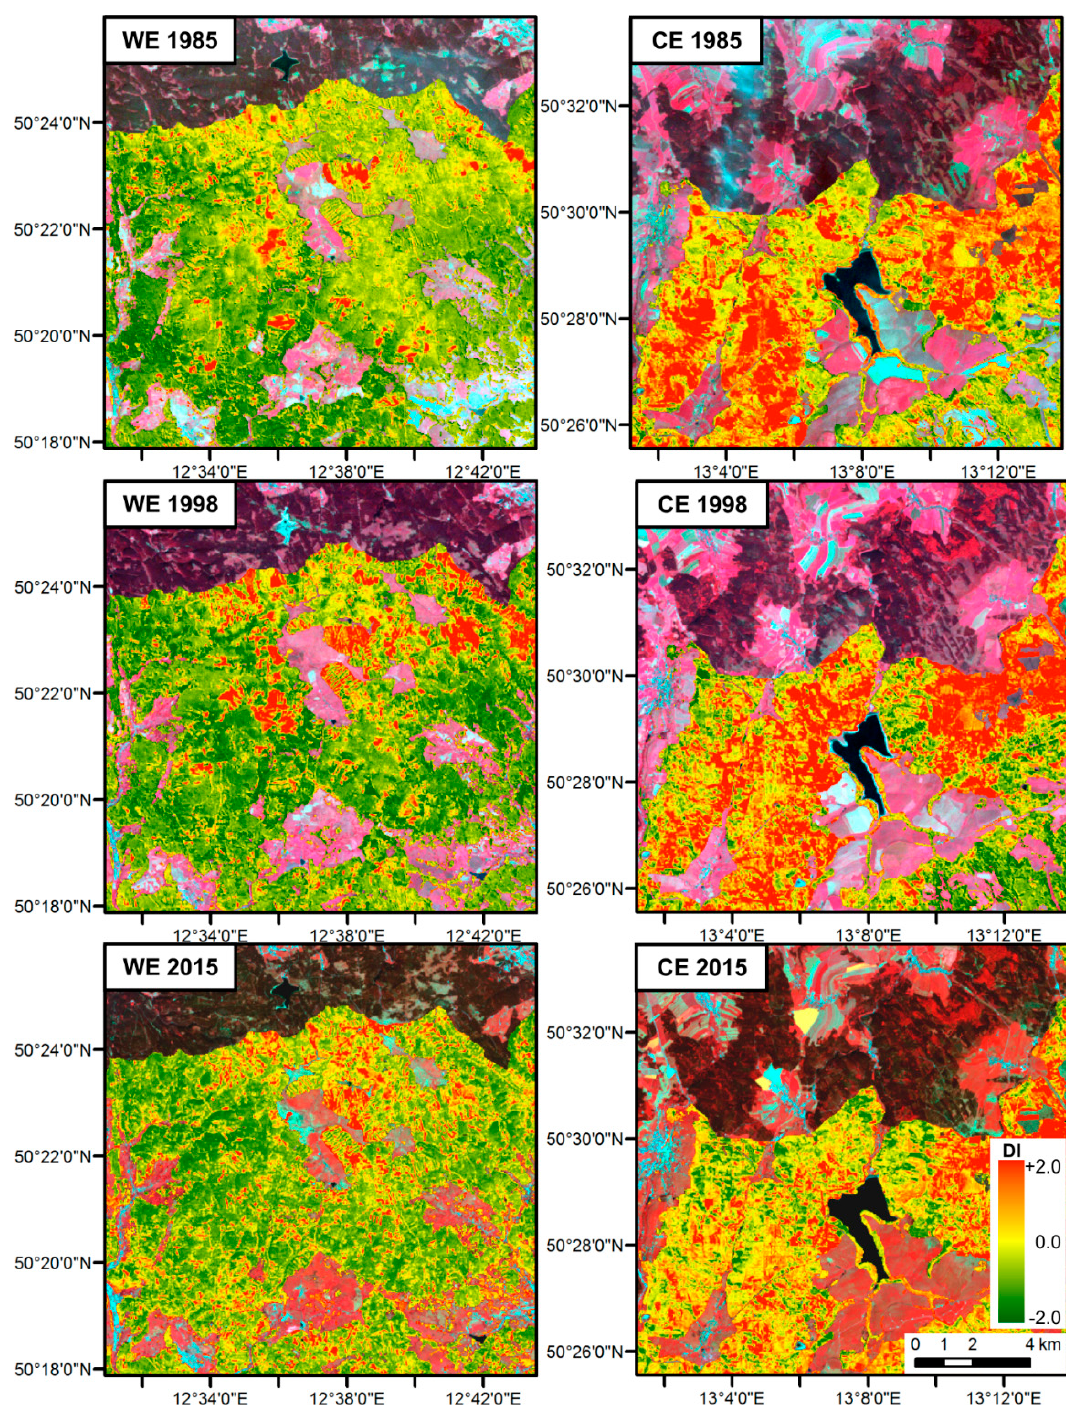
Figure 3. Disturbance index (DI) values for coniferous forests calculated from Tasseled Cap-transformed Landsat data for western (WE) and central (CE) Ore Mountains localities for 1985, 1998, and 2015. The lower DI values (shown in green) correspond to relatively less disturbed stands, whereas high DI values (shown in red) correspond to relatively more disturbed stands.